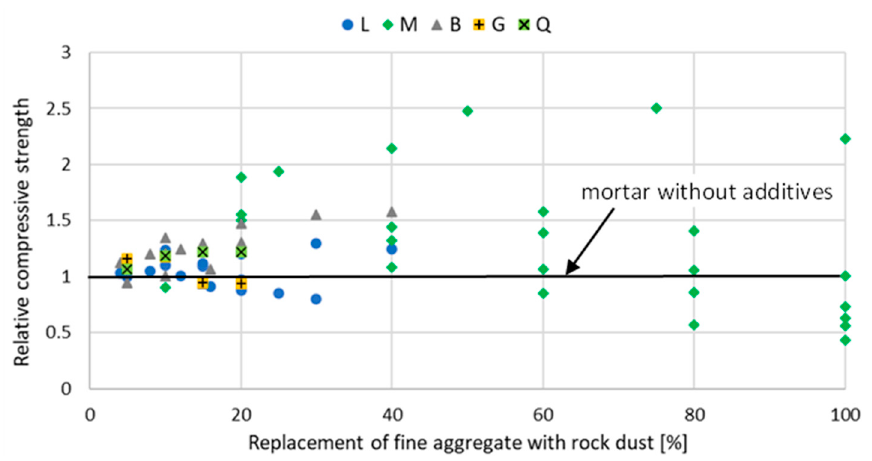
Figure 3. The effect of replacing fine aggregate with rock dust on the compressive strength of mortar after 28 days of curing: limestone dust (L) [46,55,95,97], marble dust (M) [63,67,76,86], basalt dust (B) [46,55,57,96], granite dust (G) [95], quartz dust (Q)